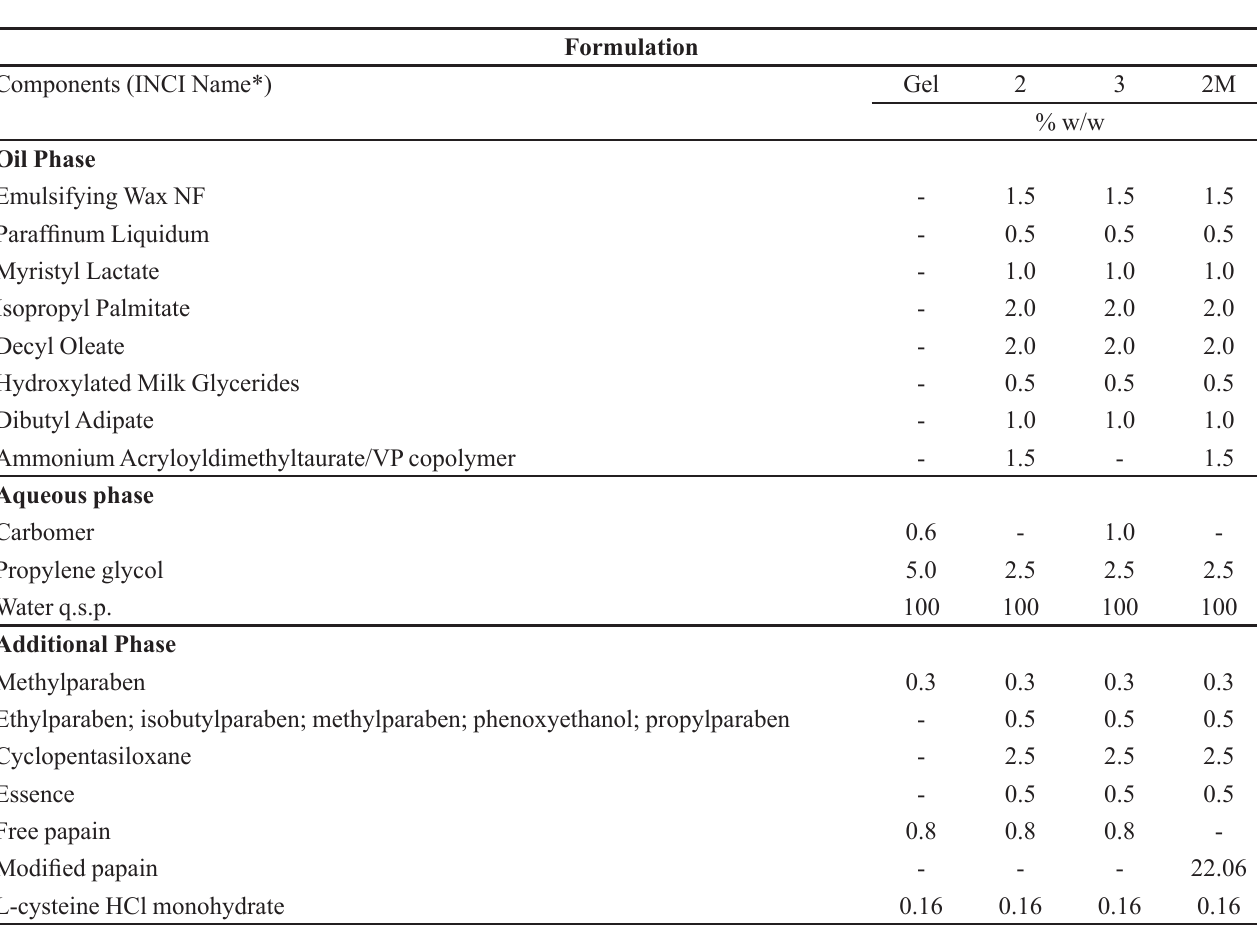
TABLE III – Formulations submitted to the Normal Stability Test. Gel (reference), preparations 2 and 3 [0.8% (w/w) of non-modified papain and 0.16% (w/w) of cysteine], and preparation 2M with 22.06% (w/v) of modified papain and 0.16% (w/w) of